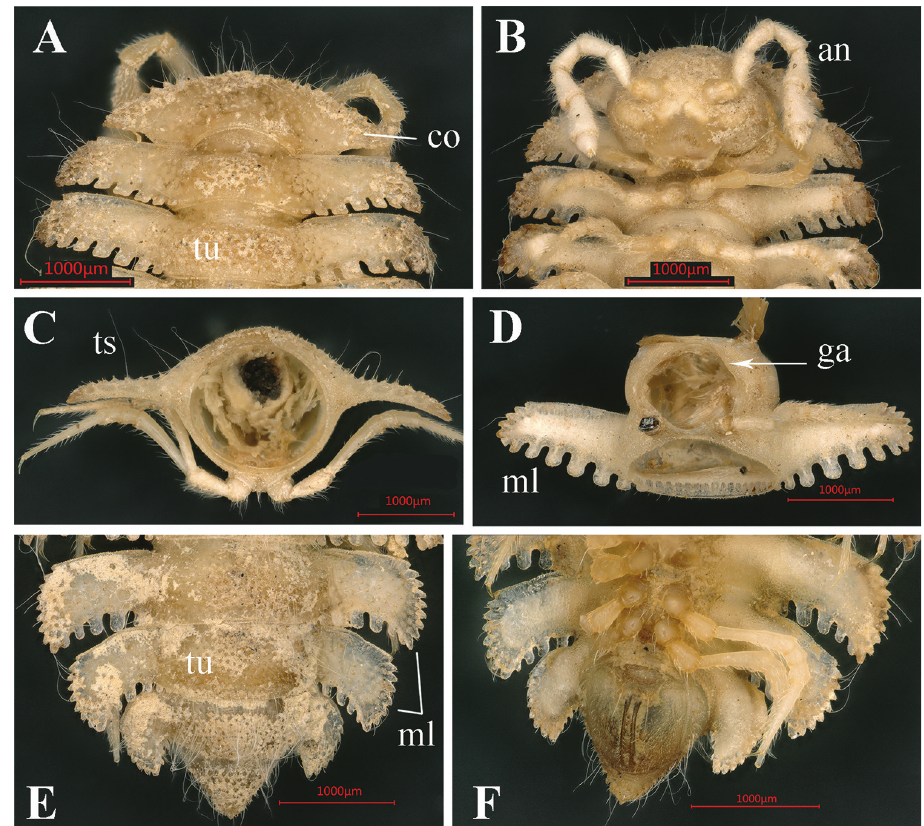
Figure 2. Trichopeltis bellus sp. n., ♂ holotype. A collum and segments 2–3, dorsal view B head and seg- ments 1–4, ventral view C cross-section of segment 8, caudal view D segment 7, ventral views E–F segments 17–19 and telson, dorsal and ventral views, respectively. Abbreviations: an = antenna; co = collum; ga = gonopod aperture; ml = marginal lobules; ts = tergal seta; tu =